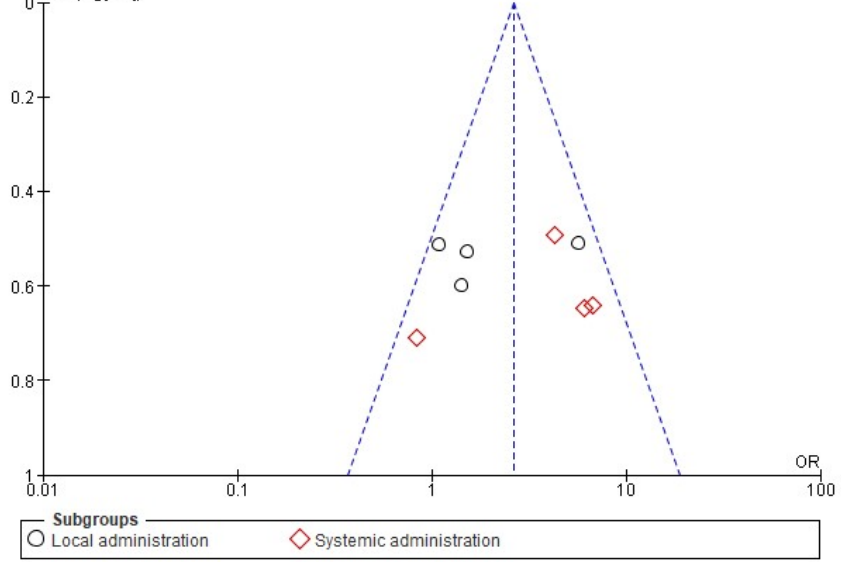
Figure 5. The publication bias [8,9,11,14,16,17,20,21].